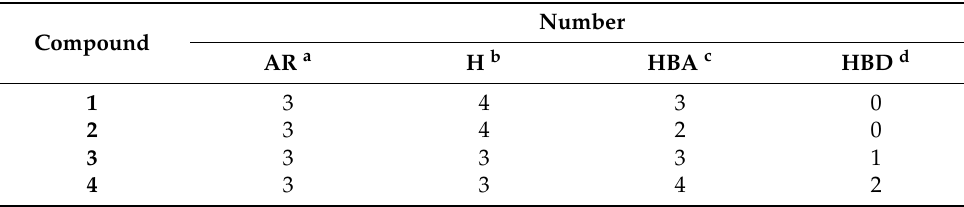
Table 2. Characteristics of the functional groups of the four 6M3SC derivatives.